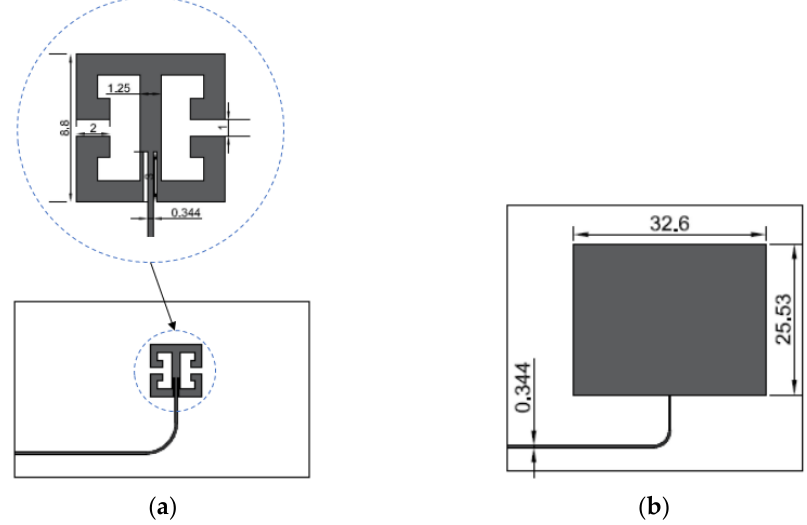
Figure 1. Sensor design ( a ) Double split-ring resonator (dSRR) microstrip sensor; ( b ) Rectangular microstrip sensor (dimensions in mm).